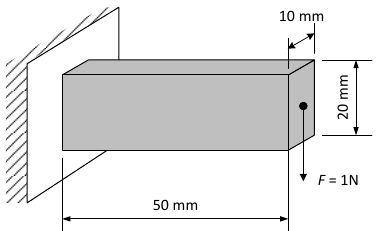
Figure 10. Design domain of a 3D cantilever beam with dimensions and boundary and loading conditions.